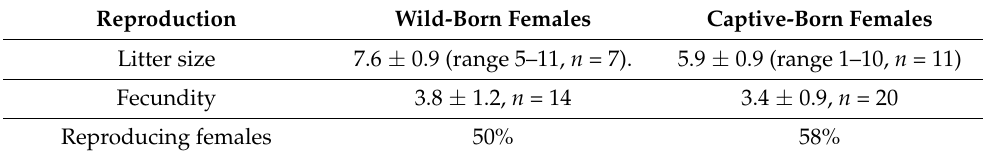
Figure 4. Pulp cavity width in relation to months after parturition. ( A ) All mink with a known death date ( n = 141). The dotted triangle marks outliers, i.e., individuals with a pulp width of less than 35% before 6 months and individuals with a pulp width less than 25% considered to be born in the years before. ( B ) Polynomial regression line modeling the pulp cavity width of individuals < one year old in relation to month after parturition was y = 0.42x 2 − 11.52x + 104.7, R 2 = 0.77, p < 0.0001. Table 1. Summary of reproduction of 41 adult mink females; of these, 34 known to have died within 7 months post-partum were used to estimate the fecundity and percent reproducing females. Mean litter size ± SE (excluding barren), fecundity ± SE (including